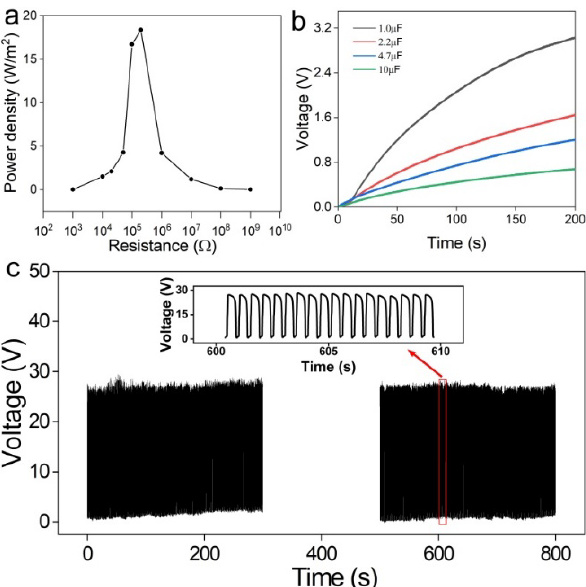
Figure 5. Charging ability of the MCM-TENG. ( a ) The relationship between power density and load resistance. ( b ) Charging curve of different capacitors (1 µ F, 2.2 µ F, 4.7 µ F, and 10 µ F). ( c ) The stability test of about 2000 cycles.